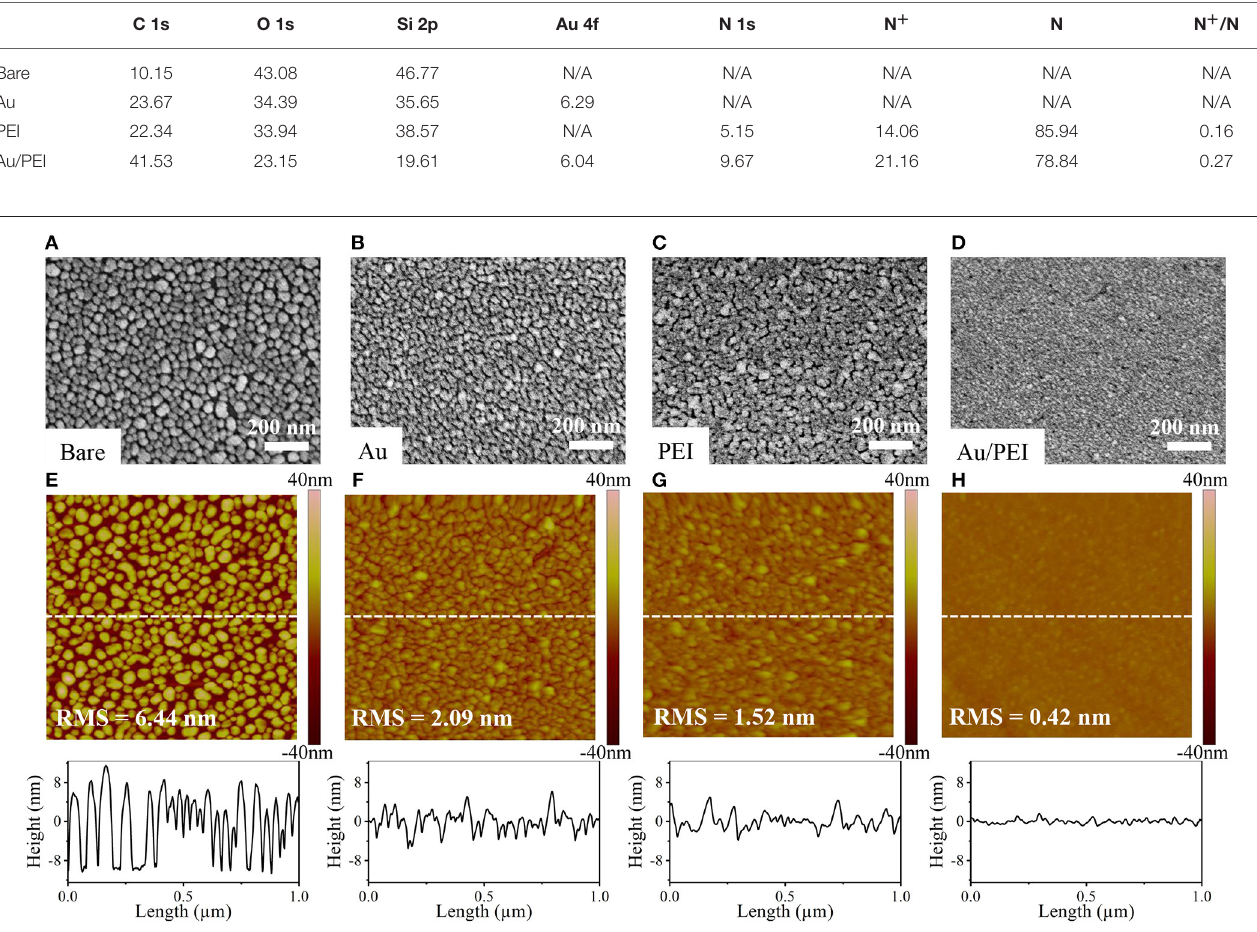
FIGURE 2 | SEM and AFM images of 8-nm-thick Ag on top of (A,E) glass, (B,F) Au, (C,G) PEI, and (D,H) Au/PEI NISLs,